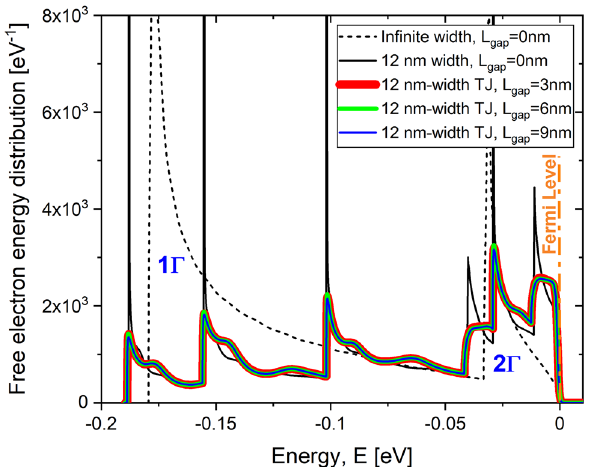
Figure 4. Free electron energy distribution for Si:P δ -layer systems. It shows a comparison of the free electron energy distribution for infinite and 12 nm-width δ -layer devices. The free electron energy distribution for the infinite-width δ -layer is normalized to a width of the device of W